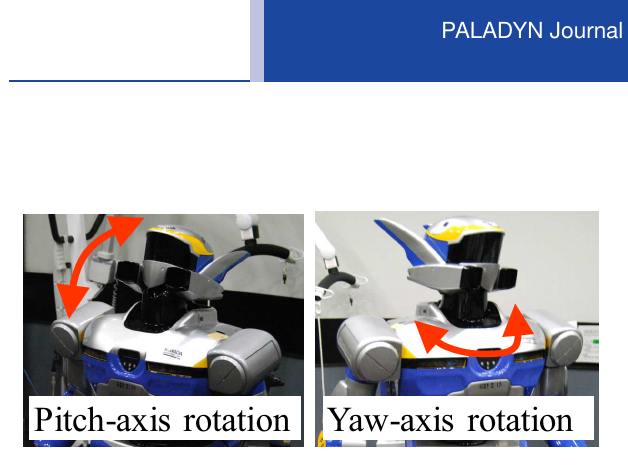
Figure 2. Head motions posed by HRP-2. Pitch-axis on the left and Yaw-axis on the right.